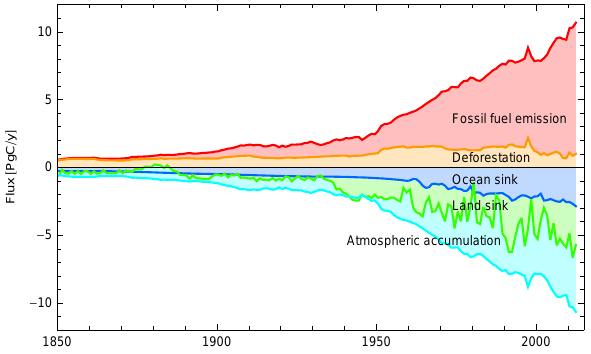
Figure C1. Global atmospheric CO 2 budget for 1959.0–2013.0 (Eq. 1), showing stacked time series of annual f Foss , annual f LUC